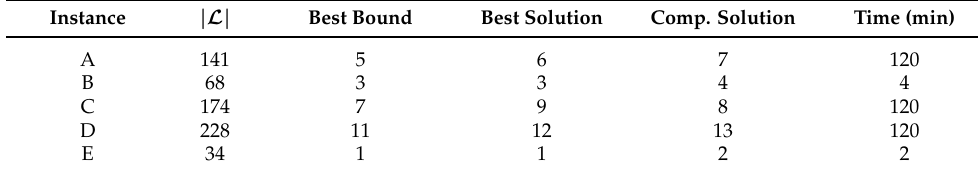
Table 3. Second run for all instances.